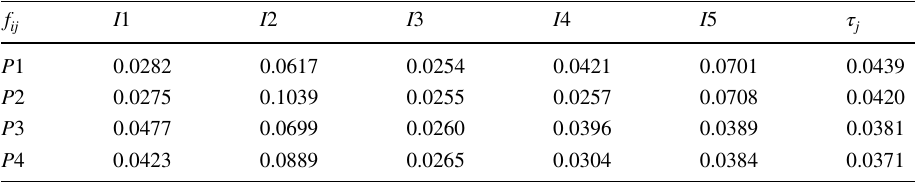
intervals of model parameters calculated by D-CRMP in homogeneous case III